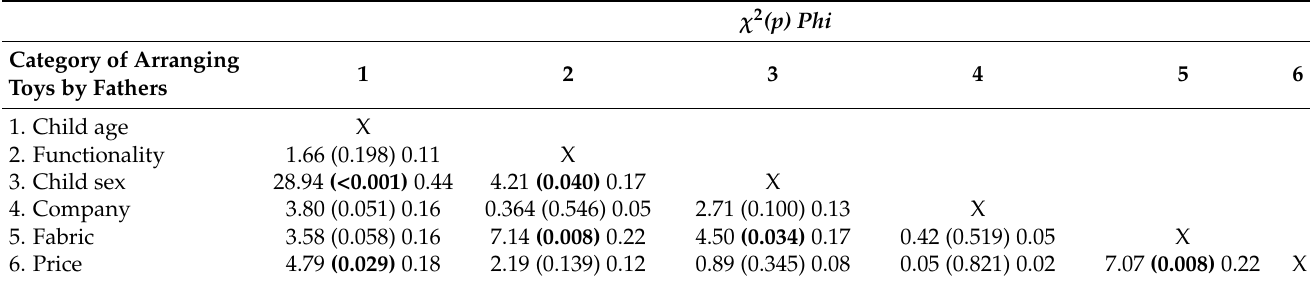
Table 3. Categories of arranging toys in stores—differences in fathers’ opinions.